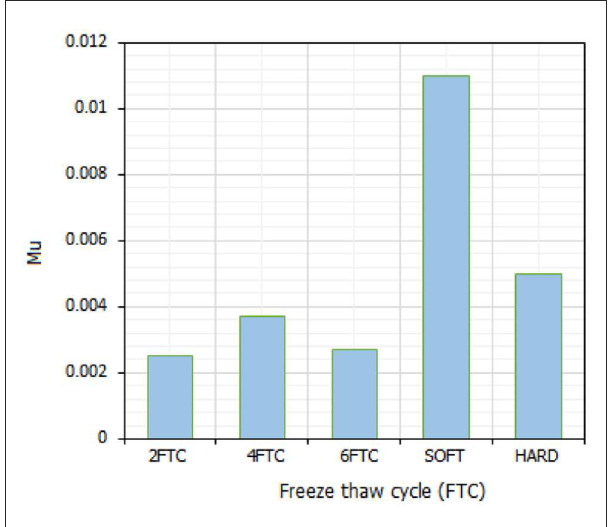
FIGURE14 Graph of µ vs. various PVA-C concentrations.